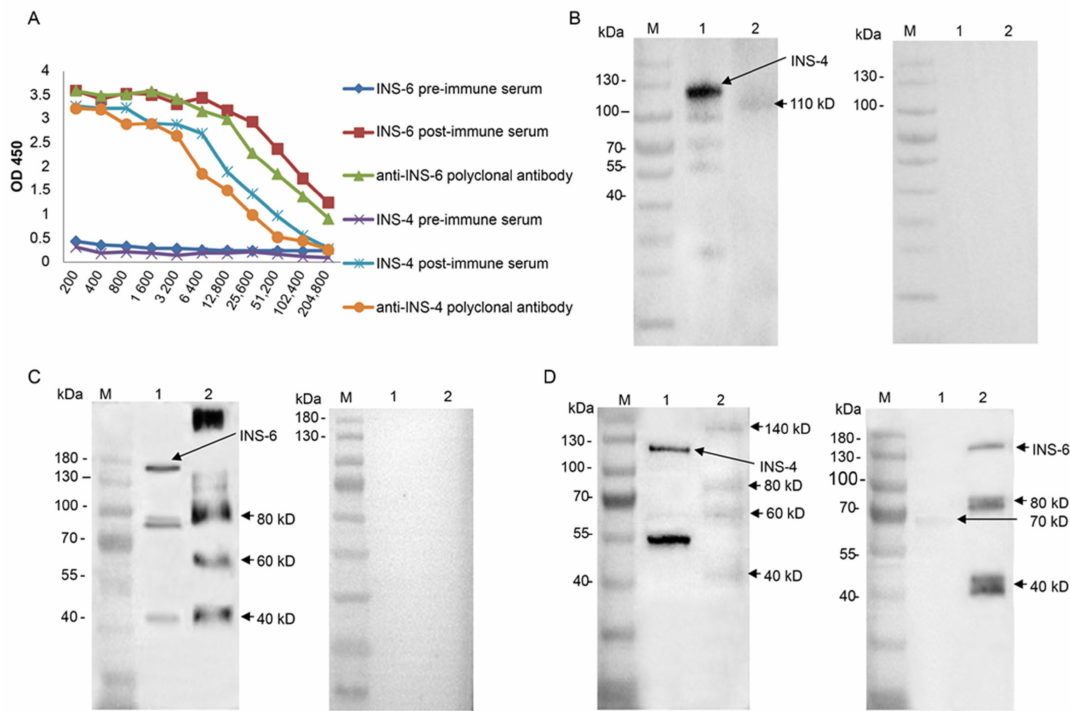
Figure 3. Expression of native CpINS-4 and CpINS-6 and cross-reactivity of polyclonal antibodies among INS proteins. ( A ) Titers of anti-CpINS-4 and anti-CpINS-6 polyclonal antibodies generated by immunizations with recombinant proteins as indicated by ELISA analysis. ( B ) Western blot analysis of native CpINS-4 protein in sporozoite lysate using polyclonal antibodies against the CpINS-4 (left panel) and preimmune sera (right panel); lane M: molecular weight markers; lane 1: purified recombinant CpINS-4 protein; lane 2: crude protein extract of sporozoites. ( C ) Western blot analysis of native CpINS-6 protein in sporozoite lysate using polyclonal antibody against the CpINS-6 (left panel) and preimmune sera (right panel); lane M: molecular weight markers; lane 1: purified recombinant CpINS-6 protein; lane 2: crude protein extract of sporozoites. ( D ) Cross-reactivity of anti-CpINS-4 antibodies (left panel) and anti-CpINS-6 antibodies (right panel) in Western blot analysis of recombinant proteins; lane M: protein size markers; lane 1: purified recombinant CpINS-4; lane 2: purified recombinant